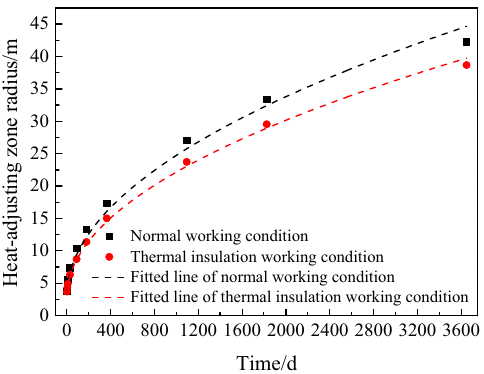
Figure 7: Change and fitting of the heat - adjusting zone radius under two working